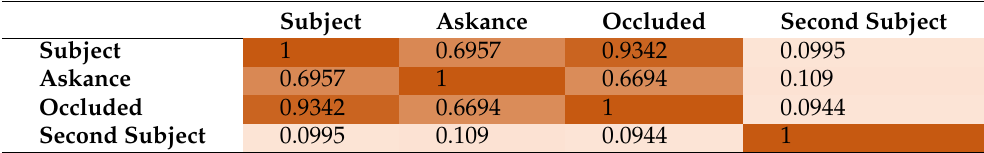
Table 2. Correlation matrix comparing average embedding distance between individuals, including occlusions and varying pose. Note the high correlation between representations of the same person and the low correlation between different people.